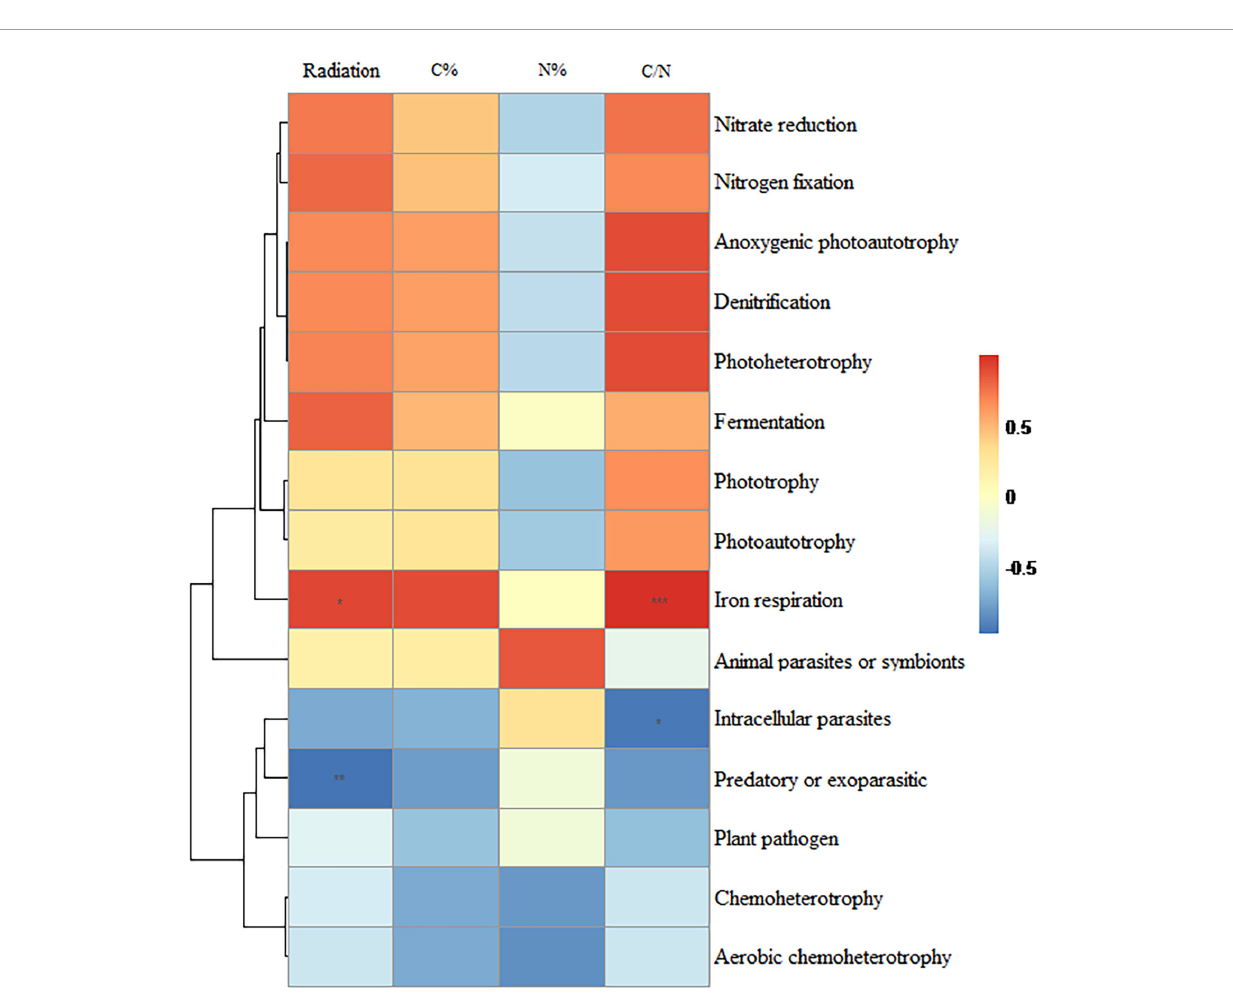
FIGURE8 Relationships between bacterial functional taxa and radiation intensity, carbon content, nitrogen content, and C/N ratio. The lines represent the relationships from cluster analysis of species/OTUs. Color depth represents the level of correlation. Significance: * < 0.05; ** < 0.01; *** < 0.001. Distance algorithm: Bray-Curtis, clustering method: